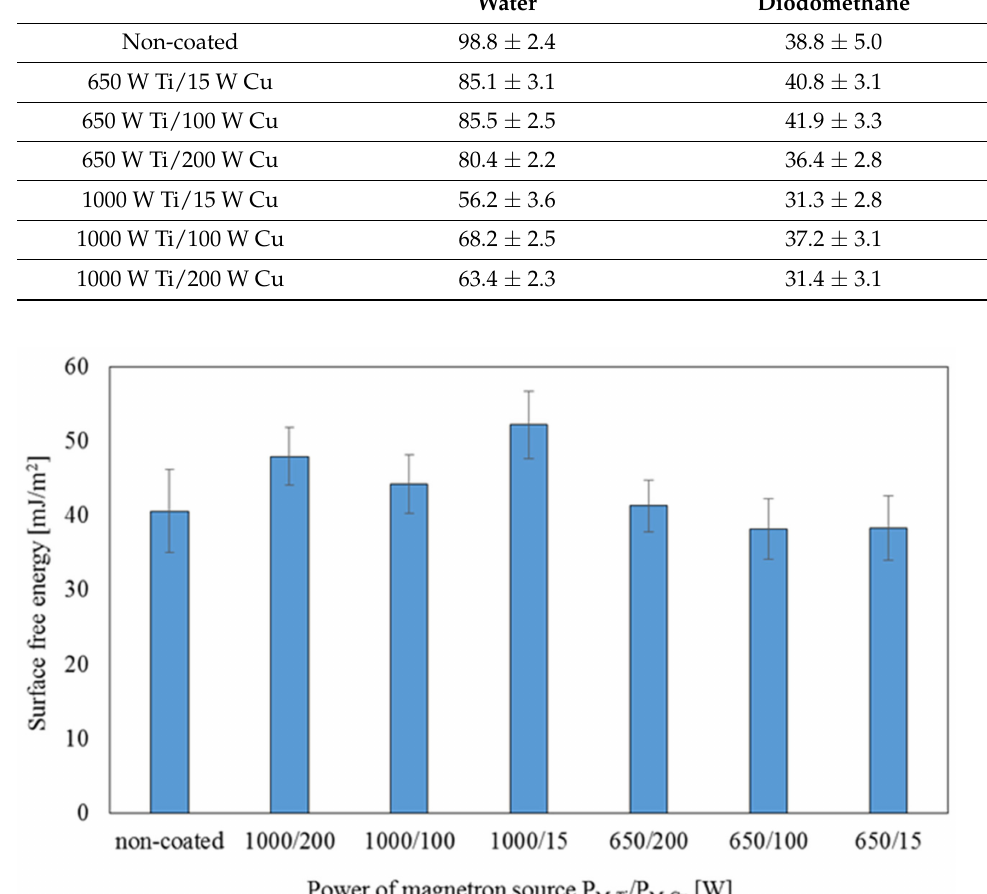
Figure 10. Comparison of the surface free energy for non-coated membrane and membranes covered with TiO 2 + CuO coatings deposited within 30 s at different magnetron power (P M-Ti /P M-Cu